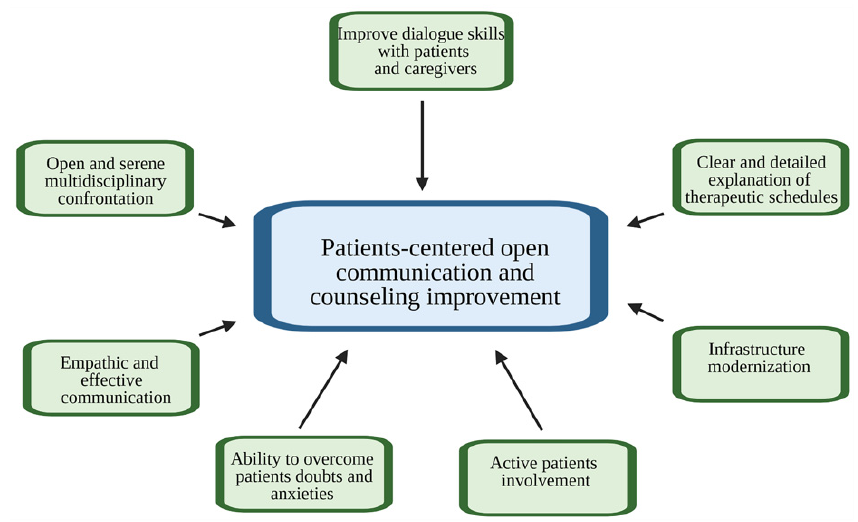
Figure 2. Objectives to be chased to improve doctor–patient counseling.